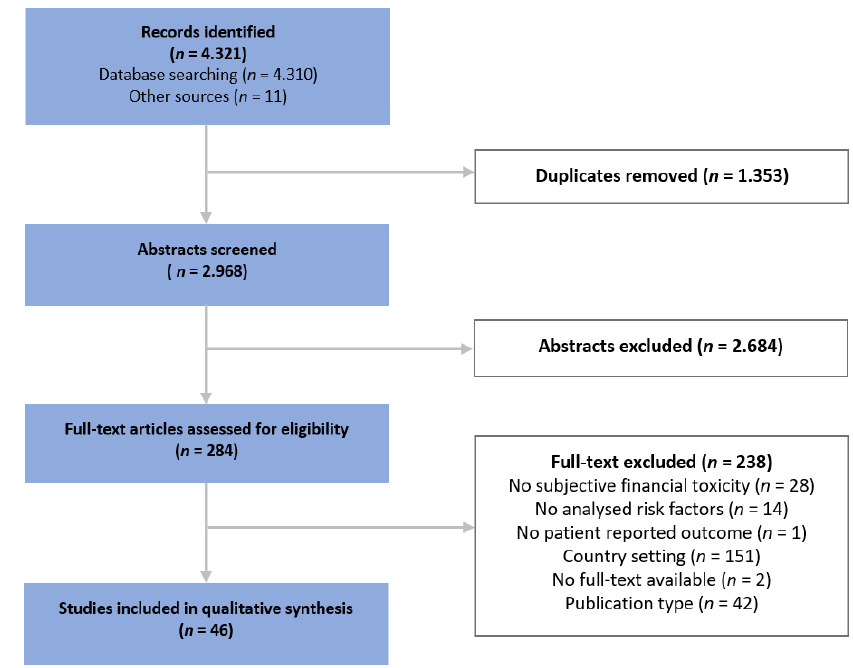
Figure 2. PRISMA flow chart of study selection.